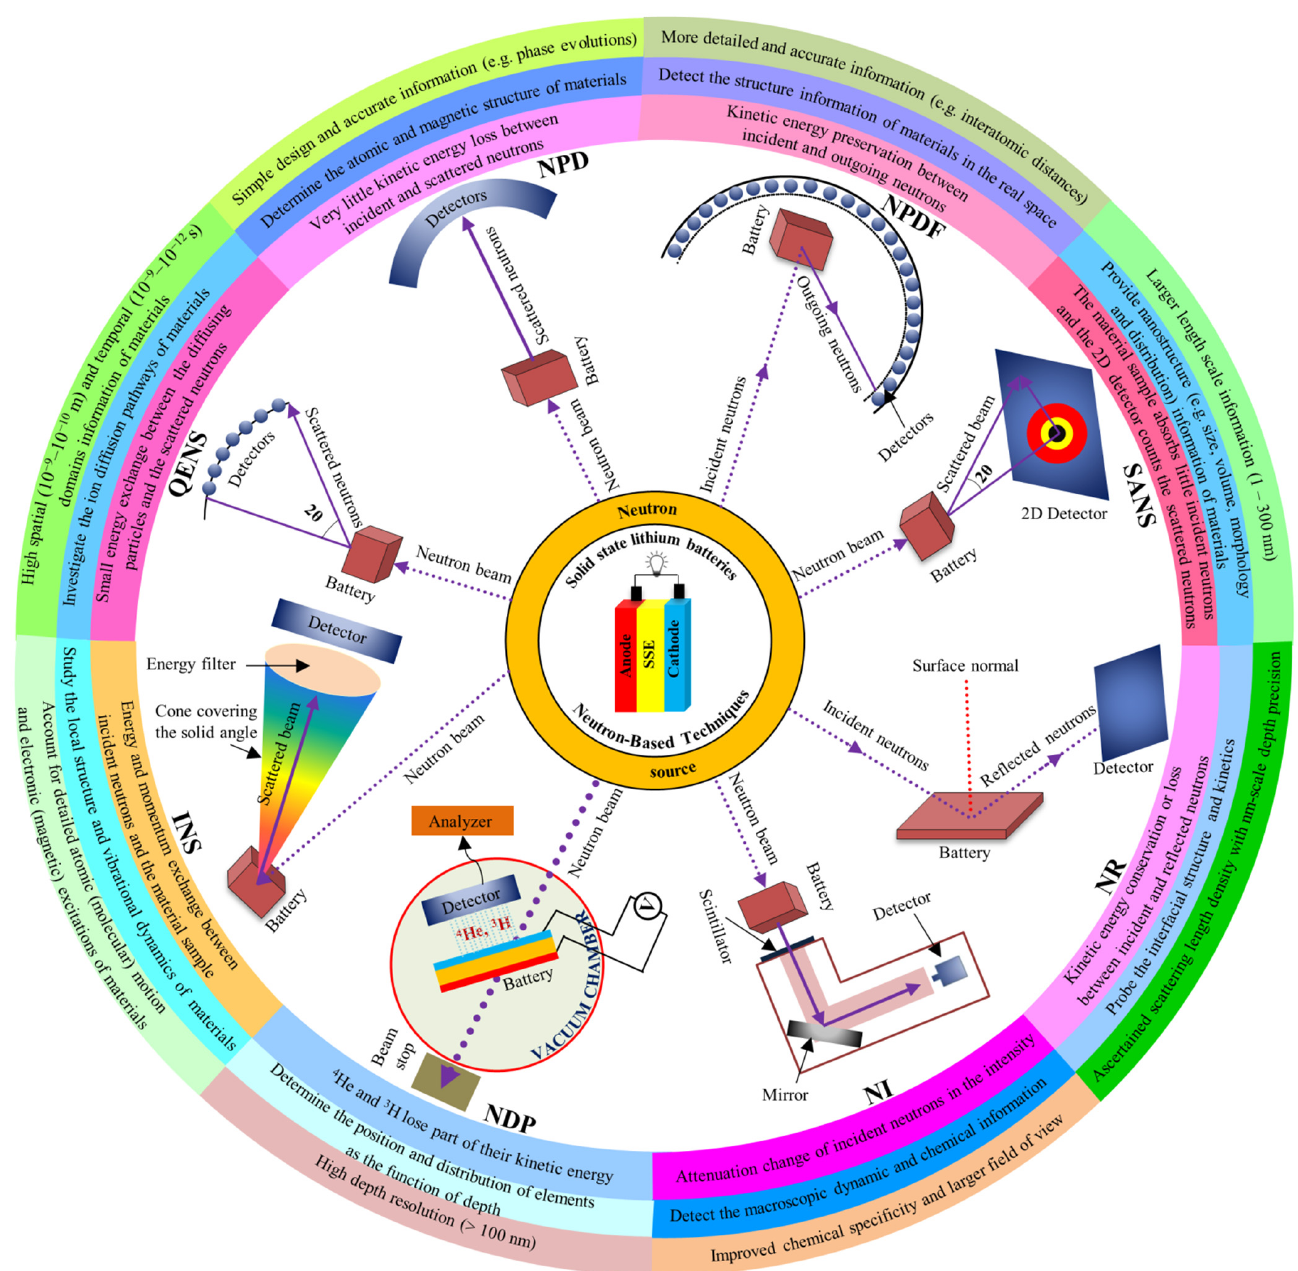
Figure 1. A summary of experimental set-ups, working mechanisms, functions, and advantages of different neutron-based characterization techniques for solid-state lithium batteries.